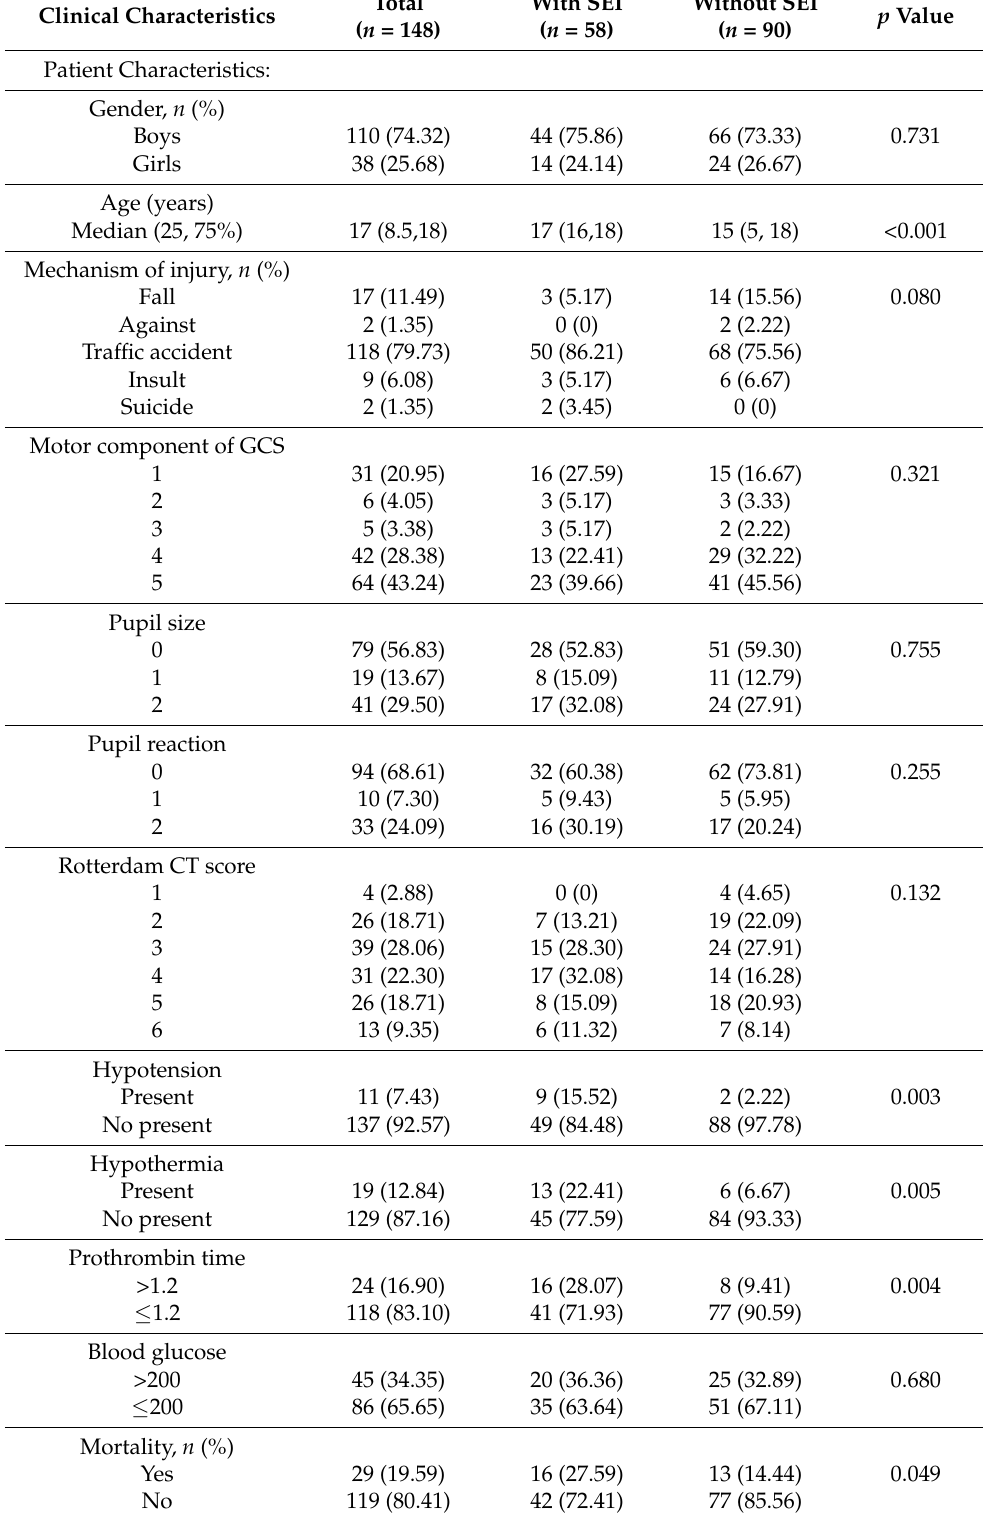
Table 1. Demographic and clinical characteristics of total, with and without serious extracranial